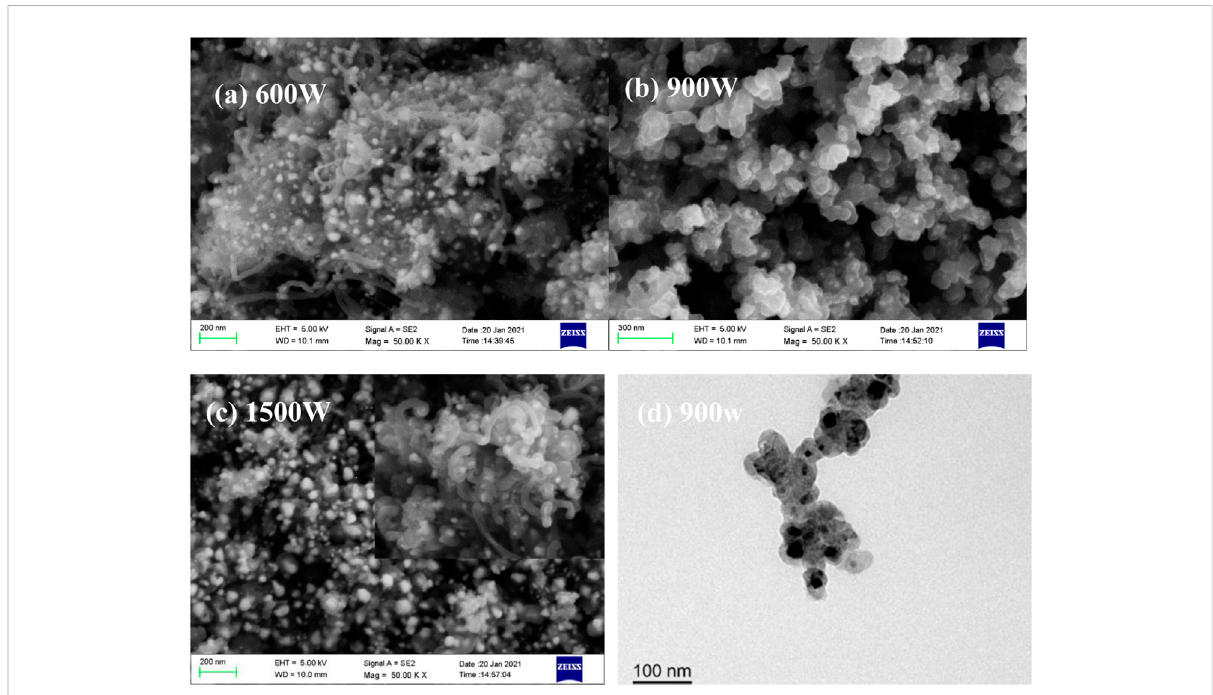
FIGURE 3 SEM (A – C) images of the products derived from nickelocene dissolved in benzene at different power and TEM (D) of the products derived at a microwave power of 900